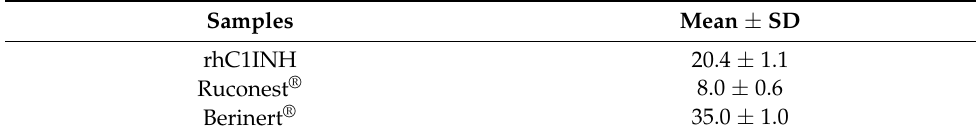
Table 6. The Neu5Ac content (mol/mol protein) determined by RP-HPLC.